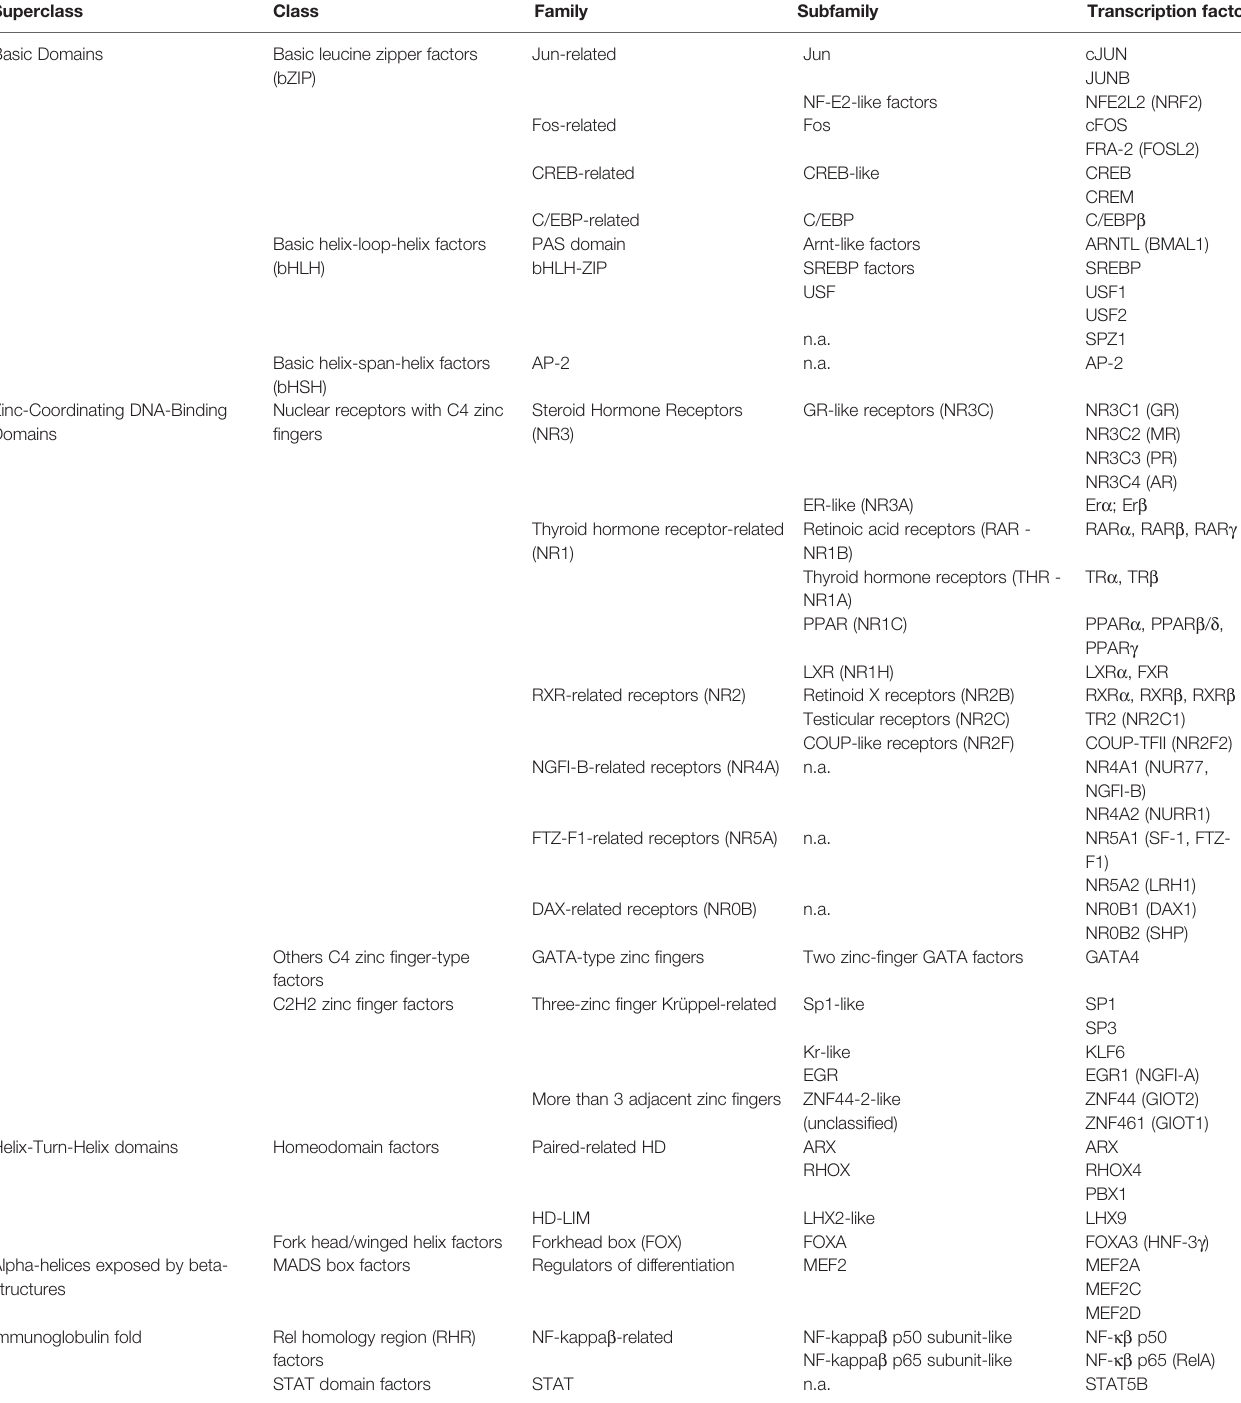
TABLE 1 | Classi fi cation of transcription factors identi fi ed in Leydig